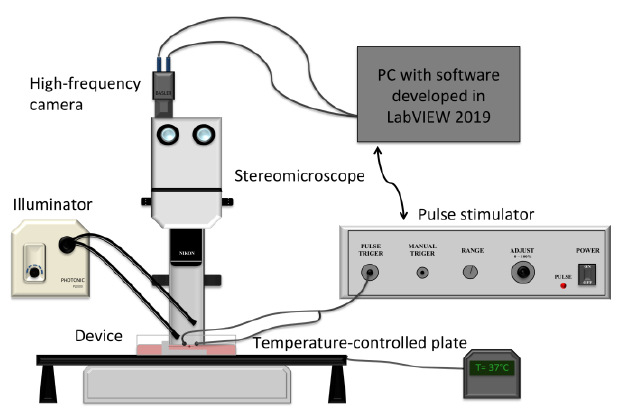
Figure 3. Schematic of the entire experimental setup used for the measurement of the contractile force of X-METs.